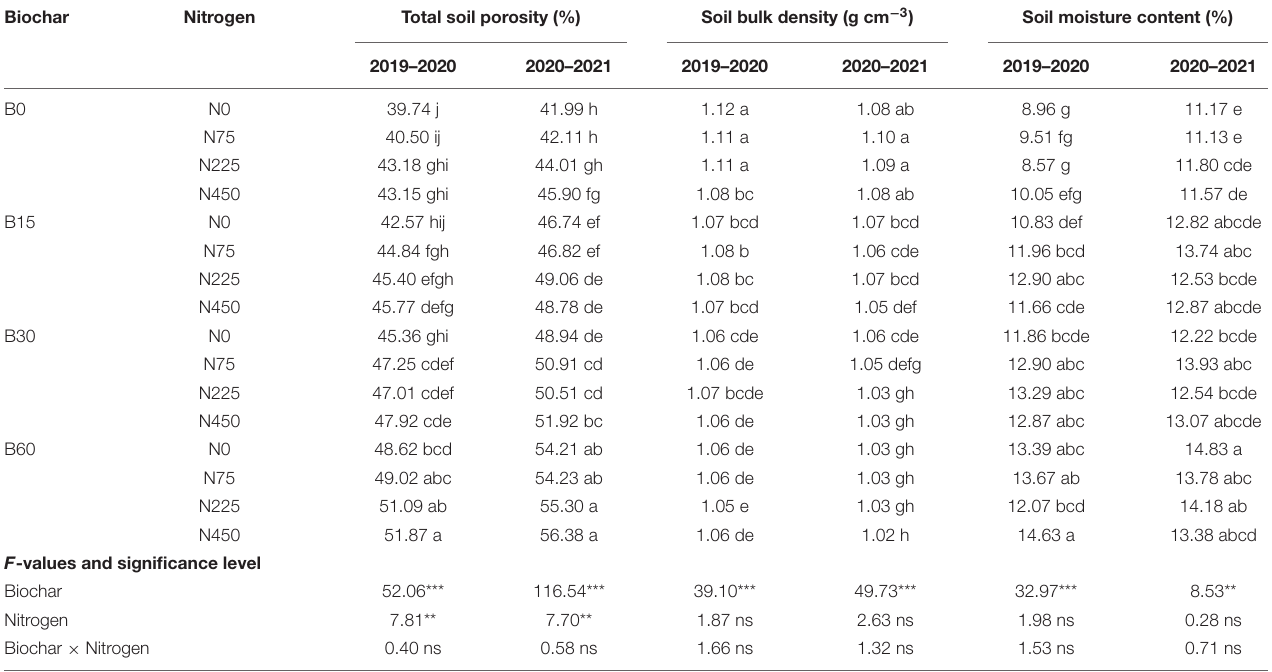
TABLE 4 | Integrated effect of biochar and nitrogen application on physical properties of soil during 2019–2020 and 2020–2021. Biochar